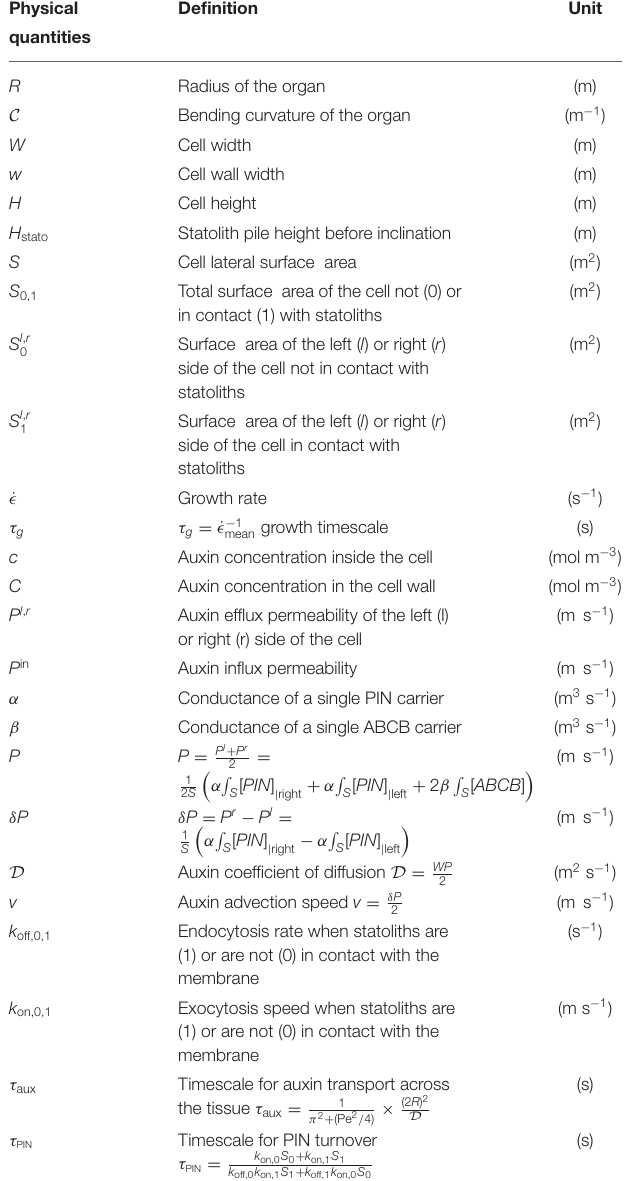
TABLE 1 | List of dimensional quantities in the model with their definition and unit. TABLE 2 | List of the dimensionless parameters used in the model with their definition and